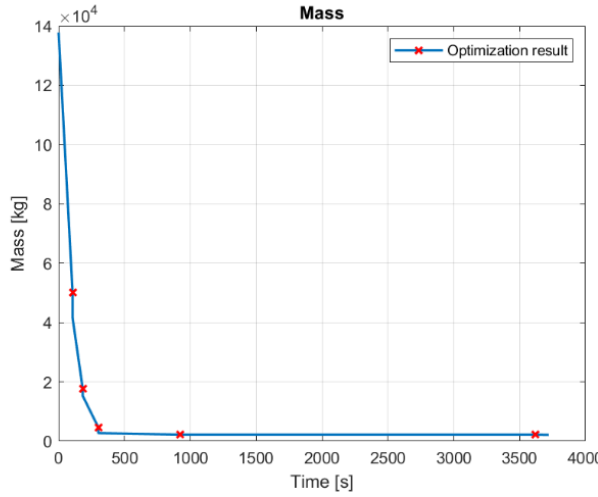
Figure 10. Mass evolution in the optimized trajectory. The red marks indicate the staging or coasting phase. Table 10. Final orbital elements for the ascend trajectory.